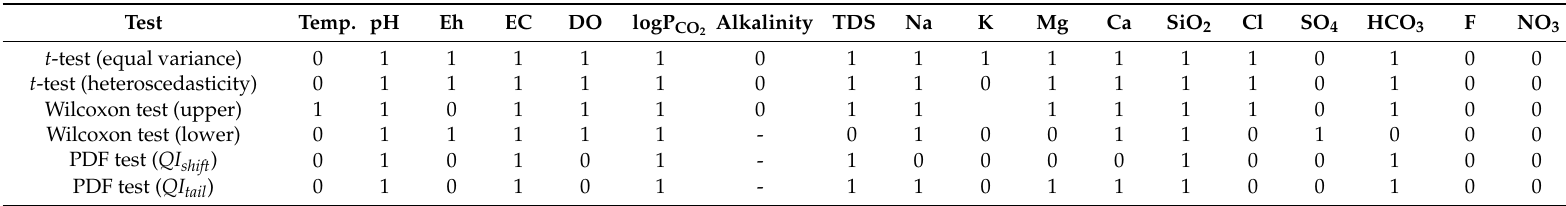
Table 12. Result of comparing PDF test with t -test and Wilcoxon test in Chungcheong Province (0 means acceptance = no difference; 1 means rejection =